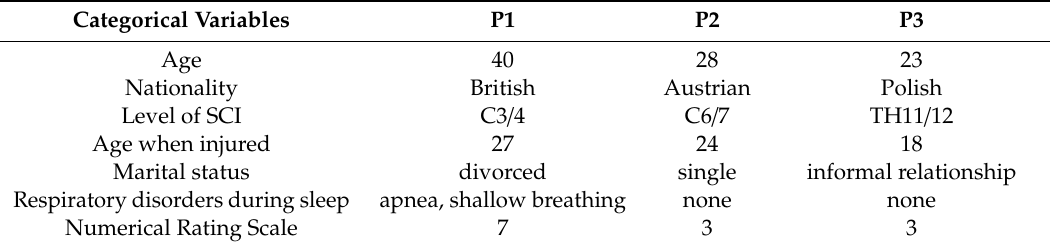
Table 1. Sociodemographic and health data of study participants. P1—participant one, P2—participant two, P3—participant three, SCI—spinal cord injury, C—cervical,